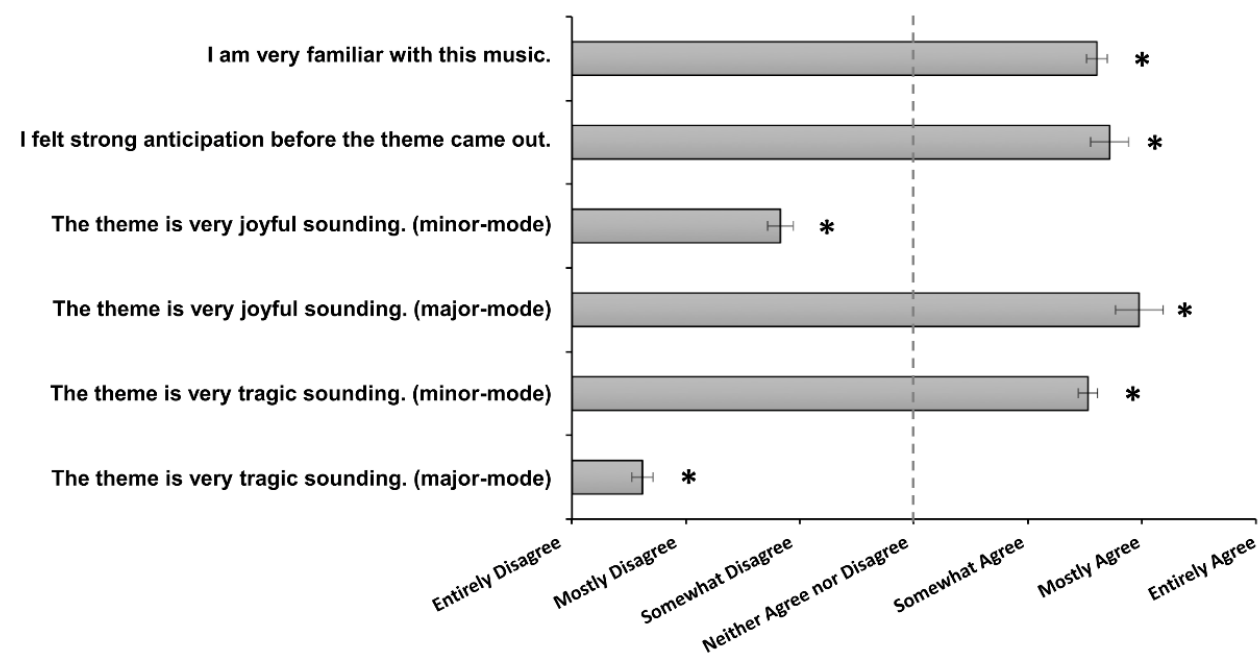
Figure 2. Participants’ ratings (7-point Likert scale). Error bars indicate standard error of the mean. * p < 0.05/6 = 0.0083.